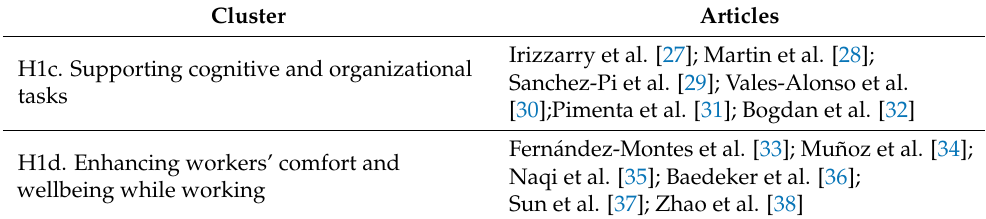
H1d. Enhancing workers’ comfort